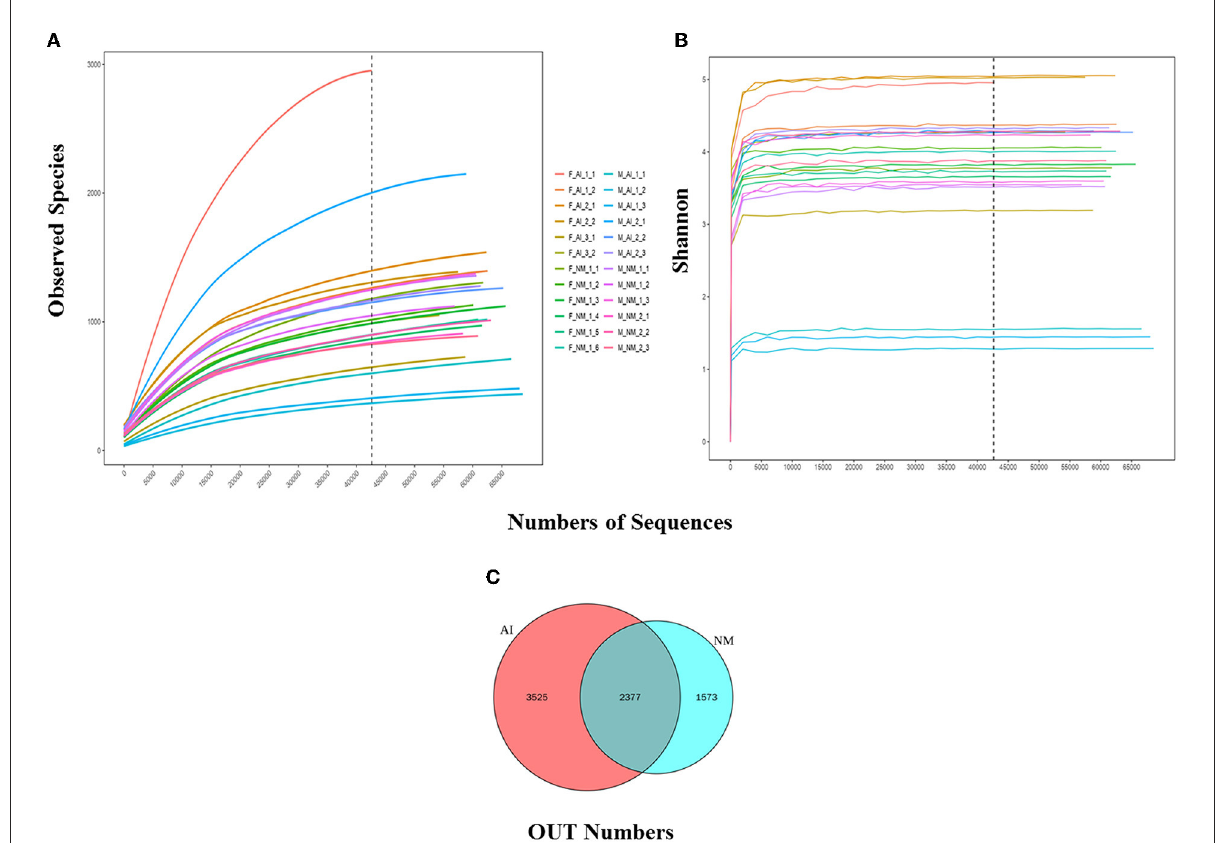
FIGURE2 Alpha diversity. (A) Rarefaction Curve for different samples and different groups; Rarefaction Curve is to randomly extract a certain amount of sequencing data from a sample, count the number of species they represent, and construct a curve based on the amount of sequencing data extracted and the number of corresponding species. The dilution curve can directly reflect the rationality of the amount of sequencing data, and indirectly reflect the abundance of species in the sample. When the curve tends to be flat, it means that the amount of sequencing data is reasonable. More data will only generate a small amount of new OTUs. Otherwise, it means that continuing sequencing may generate more new OTUs. (B) Shannon curve is constructed according to the microbial diversity index of each sample’s sequencing amount at different sequencing depths. When the curve tends to be flat, it indicates that the amount of sequencing data is large enough to reflect the vast majority of microbial information in the sample. (C) Venn graph of OTUs clustering. Venn graph shows the common and unique OTUs between the different groups.